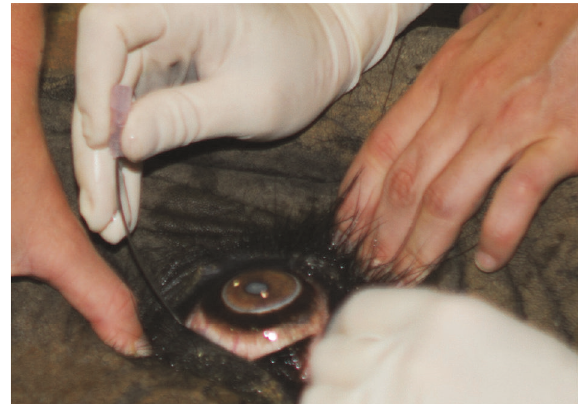
Figure 6: A modified retrobulbar block was performed using a slightly bent, 19-gauge, 2.5-inch needle to deposit approximately 25 ml of 2% mepivacaine (Pharmacia & Upjohn Company, Pfizer Inc. NY, NY, USA) through the ventral and dorsal bulbar conjunctiva behind the globe.